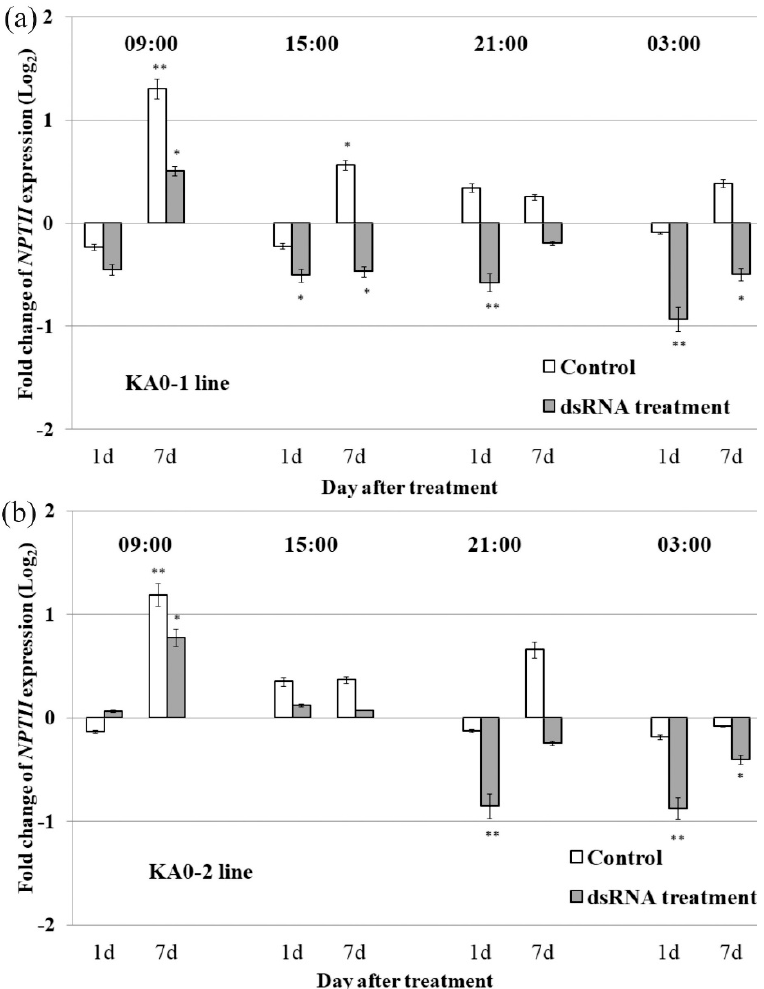
Figure 2. The effect of time of the day on the dsRNA-induced NPTII downregulation in 4-week-old Arabidopsis thaliana . Quantification the NPTII mRNAs (log 2 ) in the KA0-1 ( a ) and KA0-2 ( b ) plant lines of A. thaliana in response to foliar application of sterile filtered water (control) or NPTII -encoding dsRNA (dsRNA treatment) at different times of the day, relative to NPTII expression in the same plants before treatments. 09:00, 15:00, 21:00, and 03:00 – time for dsRNA treatment and RNA isolation. The abaxial and adaxial leaf surface of an individual plant was treated by sterile soft brushes with 0.35 µg/µL of NPTII - ds RNA or water (100 µL per individual plant). RNA was isolated from the same individual plant before, 1 day, and 7 days after treatments (two independent experiments). qRT-PCR data are presented as mean ± SE. *, **—significantly different from the untreated plant at p ≤ 0.05 and 0.01, respectively, according to the Student’s t